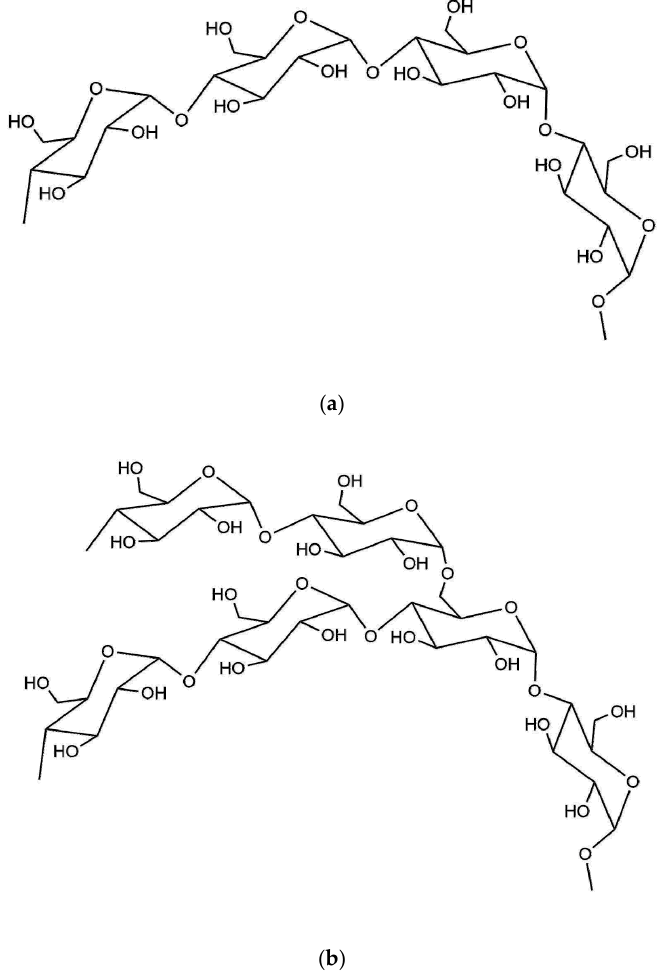
Figure 6. Chemical structure of ( a ) amylose and ( b ) amylopectin.